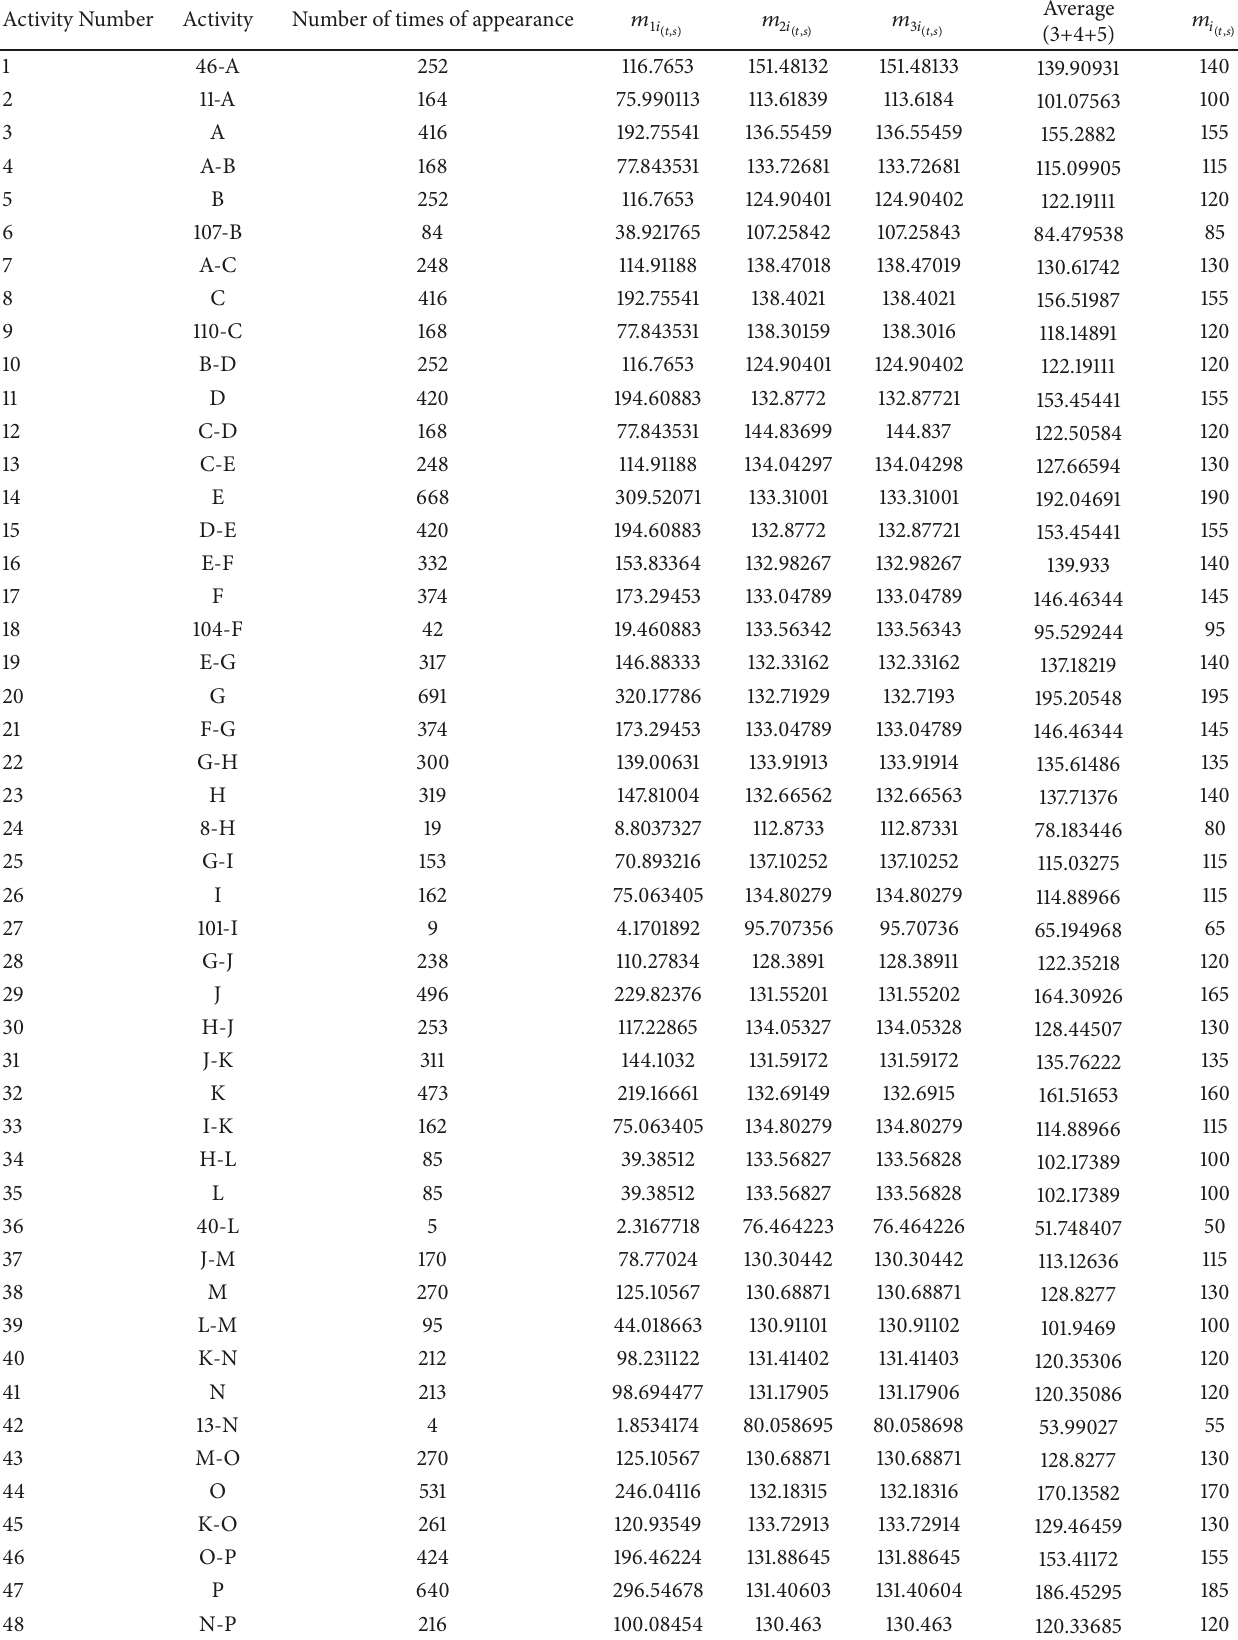
Table 4: Margin Reallocation For Real World Case Study. (Unit: